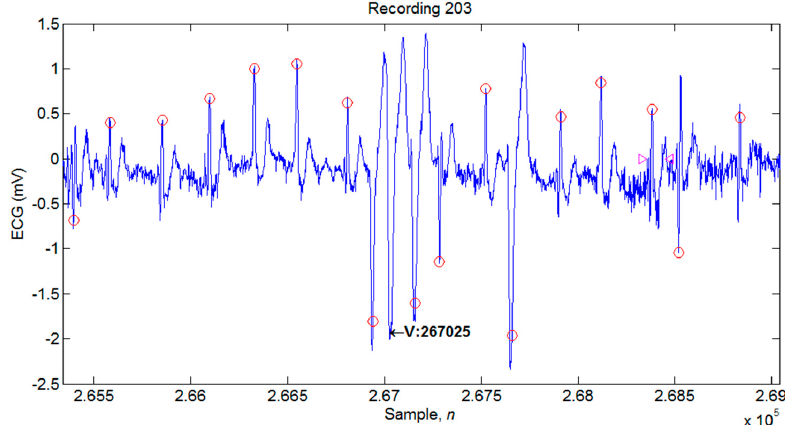
Appl. Sci. 2019 , 9 , x FOR PEER REVIEW Figure 14. Illustration of the detection failures caused by large-amplitude artifacts.